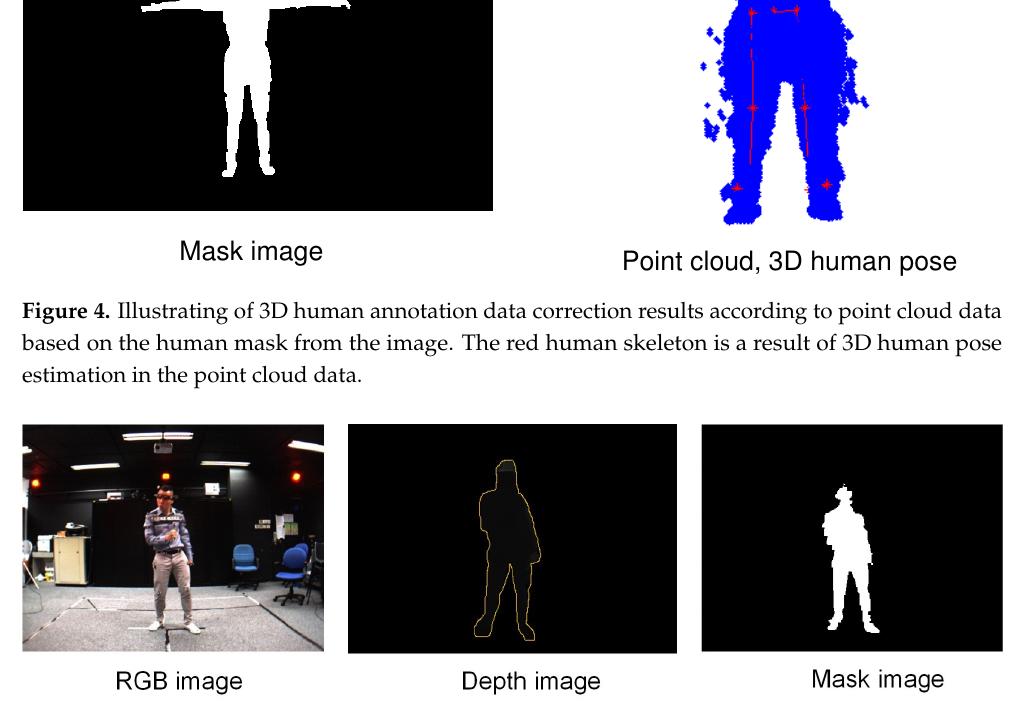
Figure 5. Illustration of image data of an unmarked human and masked image. Human depth data is delimited by a yellow border. The depth value of the human pixels is greater than 0 (which is the distance from the camera to the surface of the body) and is a gray color, the other pixels are the background and is black color. The depth image is the result of mapping from the human mask to the depth image obtained from the